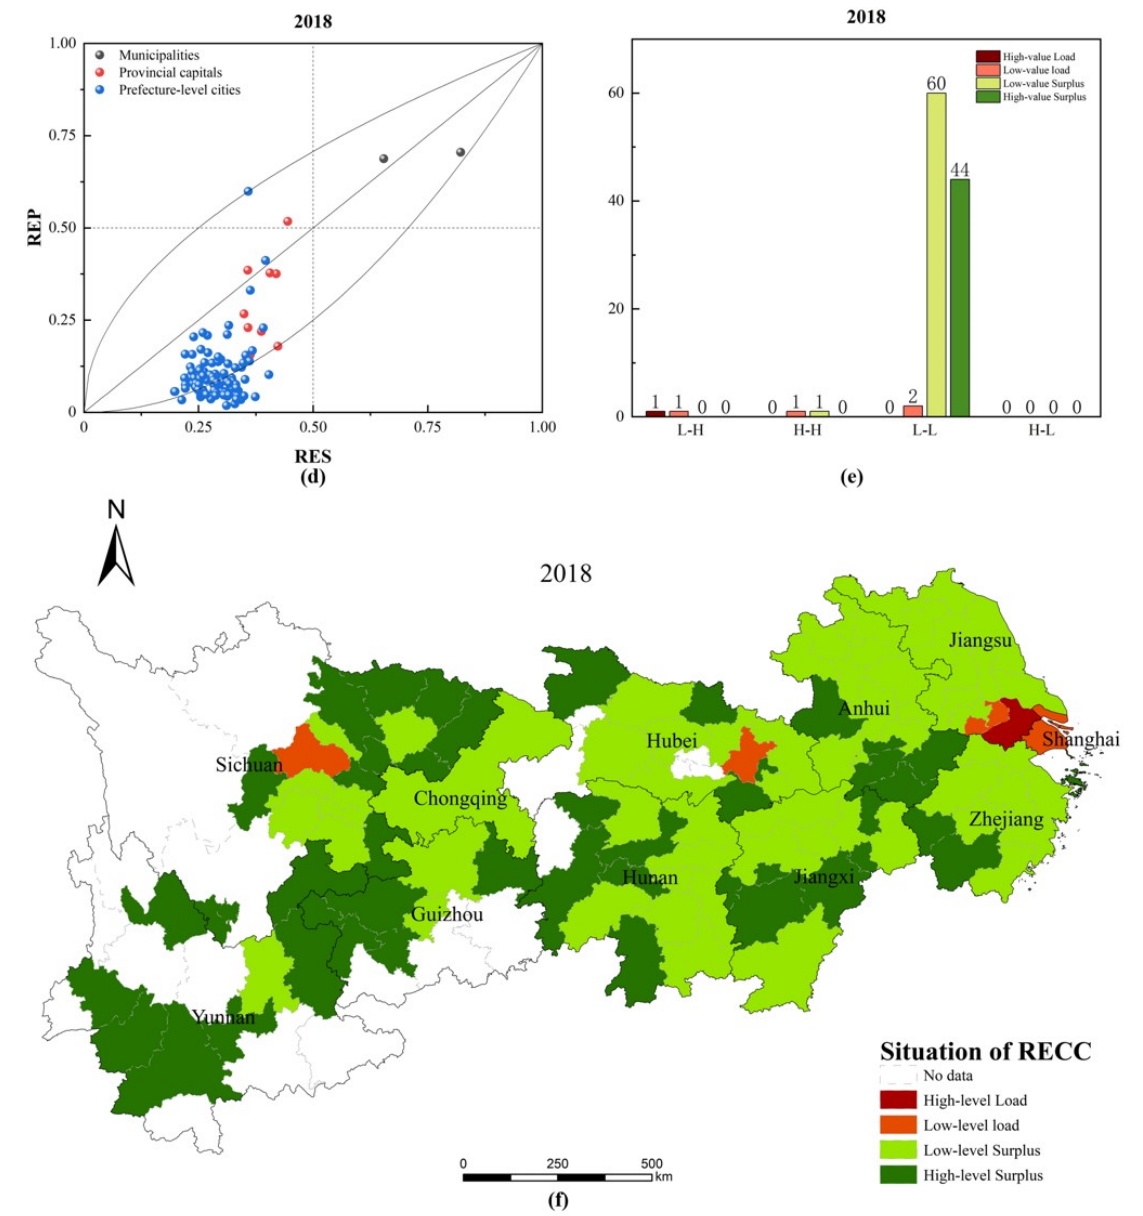
Figure 7. RECC status and city types of 110 cities in the Yangtze River Economic Belt in 2009 and 2018.